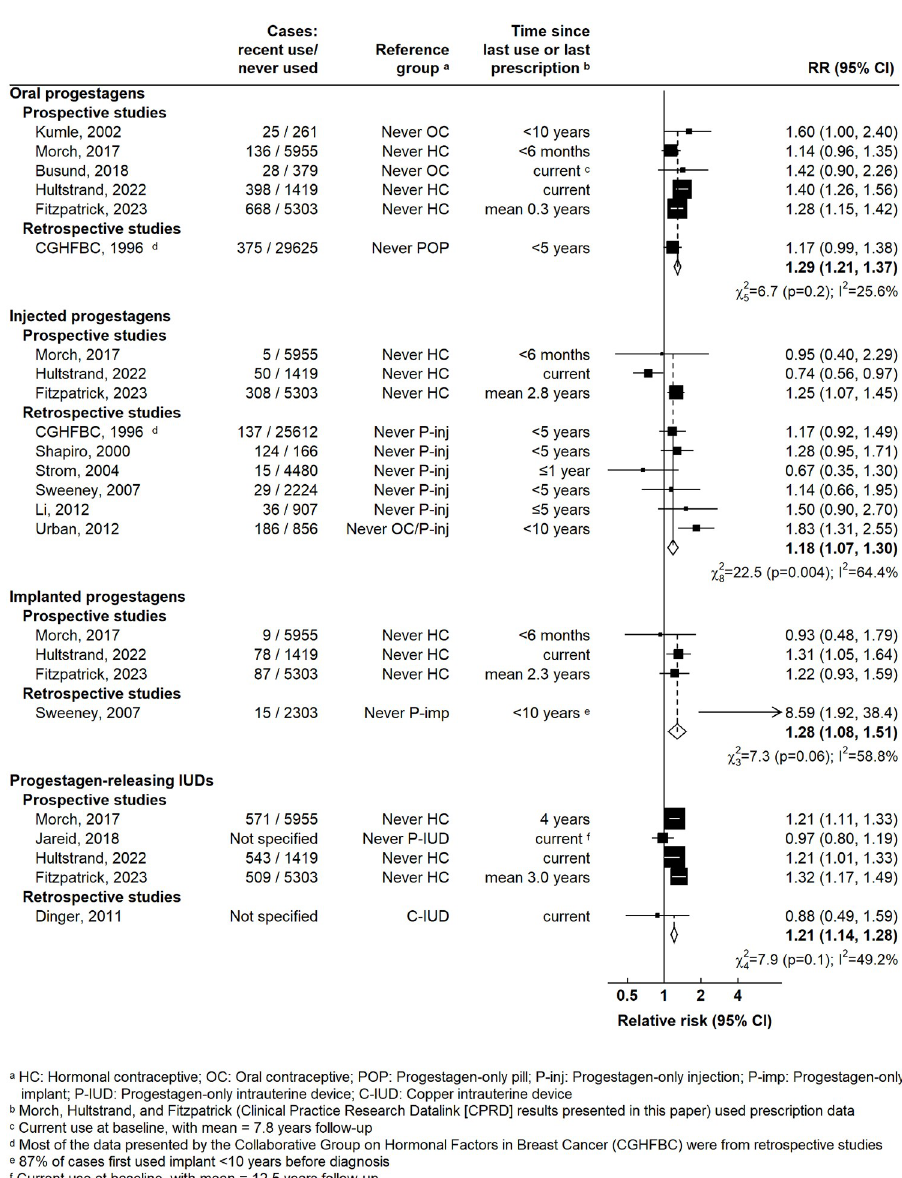
Fig 5. Meta-analysis of the RR for breast cancer associated with current or recent use of progestagen-only contraceptives. Results are presented separately for studies that recorded information prospectively, i.e., where information on contraceptive use was recorded prior to breast cancer diagnosis, and for studies that recorded information retrospectively. CI, confidence interval; RR, relative risk.